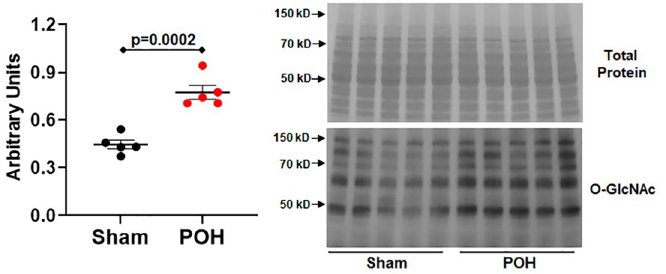
Fig 2. Global protein O-GlcNAc level in pressure-overload hypertrophy (POH) and sham (Sham) groups. Immunoblots are shown for global protein O-GlcNAc levels using the RL2 antibody normalized to protein staining shown above. Bars are mean ± standard error of the mean. N = 5 per